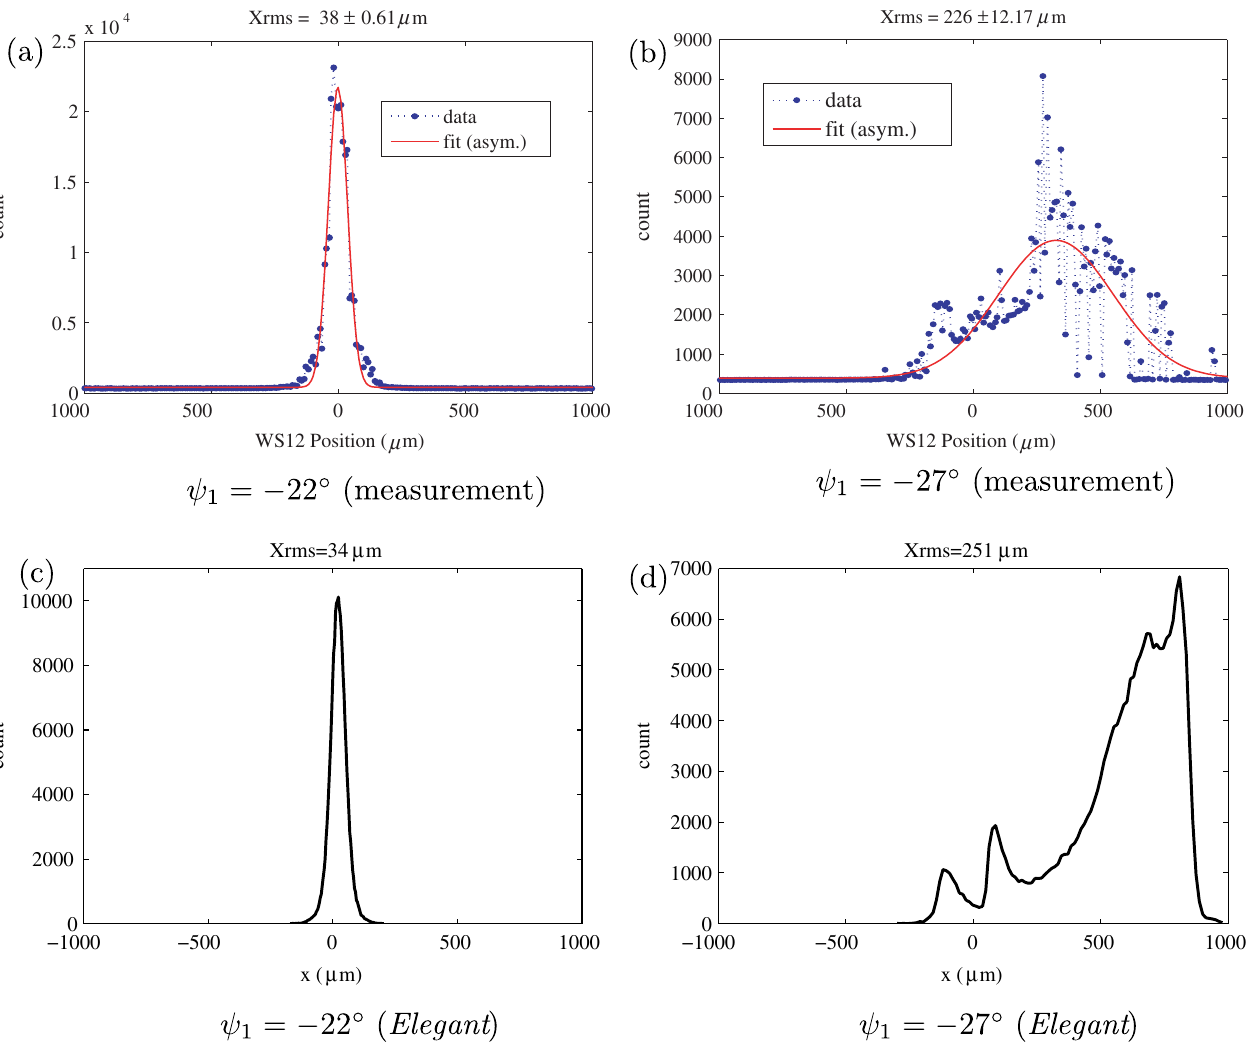
FIG. 6. (Color) Measured and simulated horizontal beam profiles at the post-BC1 wire scanner for two L1S phases. (a) c 1 ¼ (cid:2) 22 (cid:1) (measurement). (b) c 1 ¼ (cid:2) 27 (cid:1) (measurement). (c) c 1 ¼ (cid:2) 22 (cid:1) ( ELEGANT ). (d) c 1 ¼ (cid:2) 27 (cid:1) ( ELEGANT